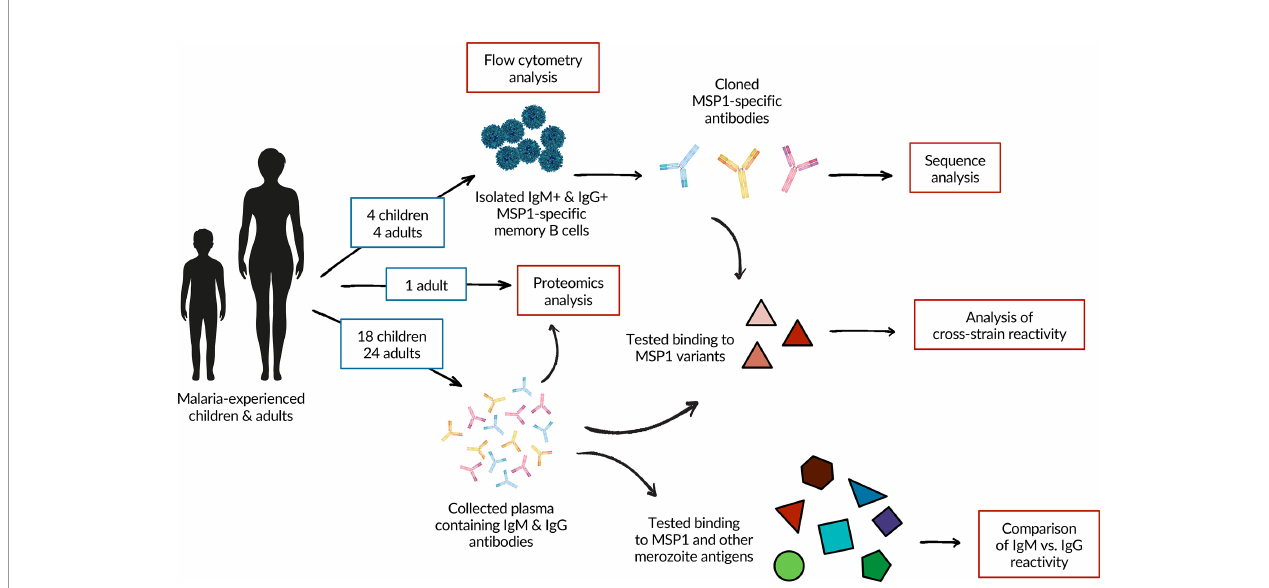
FIGURE 1 | A schematic overview of the experimental approach and analyses performed in this study. A total of 26 adults and 20 children were included in the study. Samples from four children and four adults were used for fl ow cytometric analysis and the isolation of PfMSP1-speci fi c B cells. Two individuals from each group were also included in the analysis of plasma IgM and IgG responses against PfMSP1 and other merozoite antigens. See Supplementary Table 1 for details on which donors were included in which